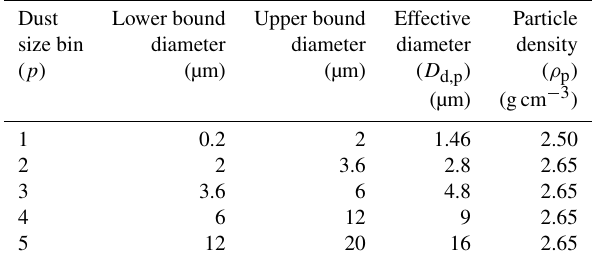
Table 2. Dust particle size bins and their associated attributes, pre- sented here in µm but handled in units of centimeters within the